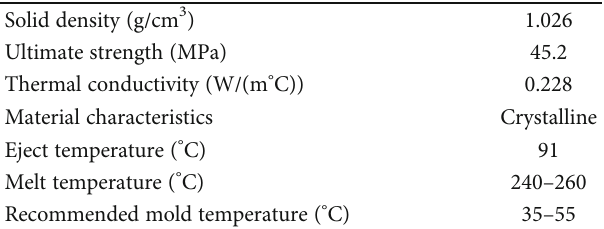
Figure 1: Injection-molded pallet. (a) Twelve fi lling gates in the pallet. (b) The dimensions of the pallet in front view. (c) Isometric view of the top side of the pallet. (d) Isometric view of cooling fl ow system on the top side of the pallet. Table 1: Material properties of recycled